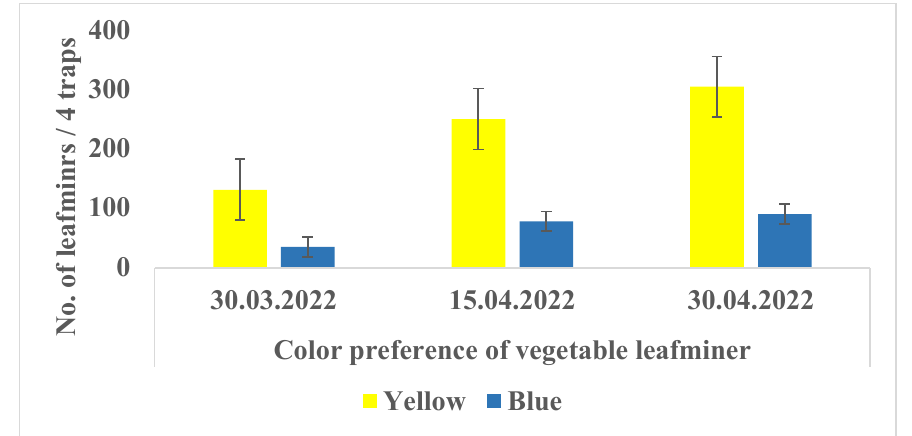
Figure 2. Color preference of Liriomyza spp. 2022.